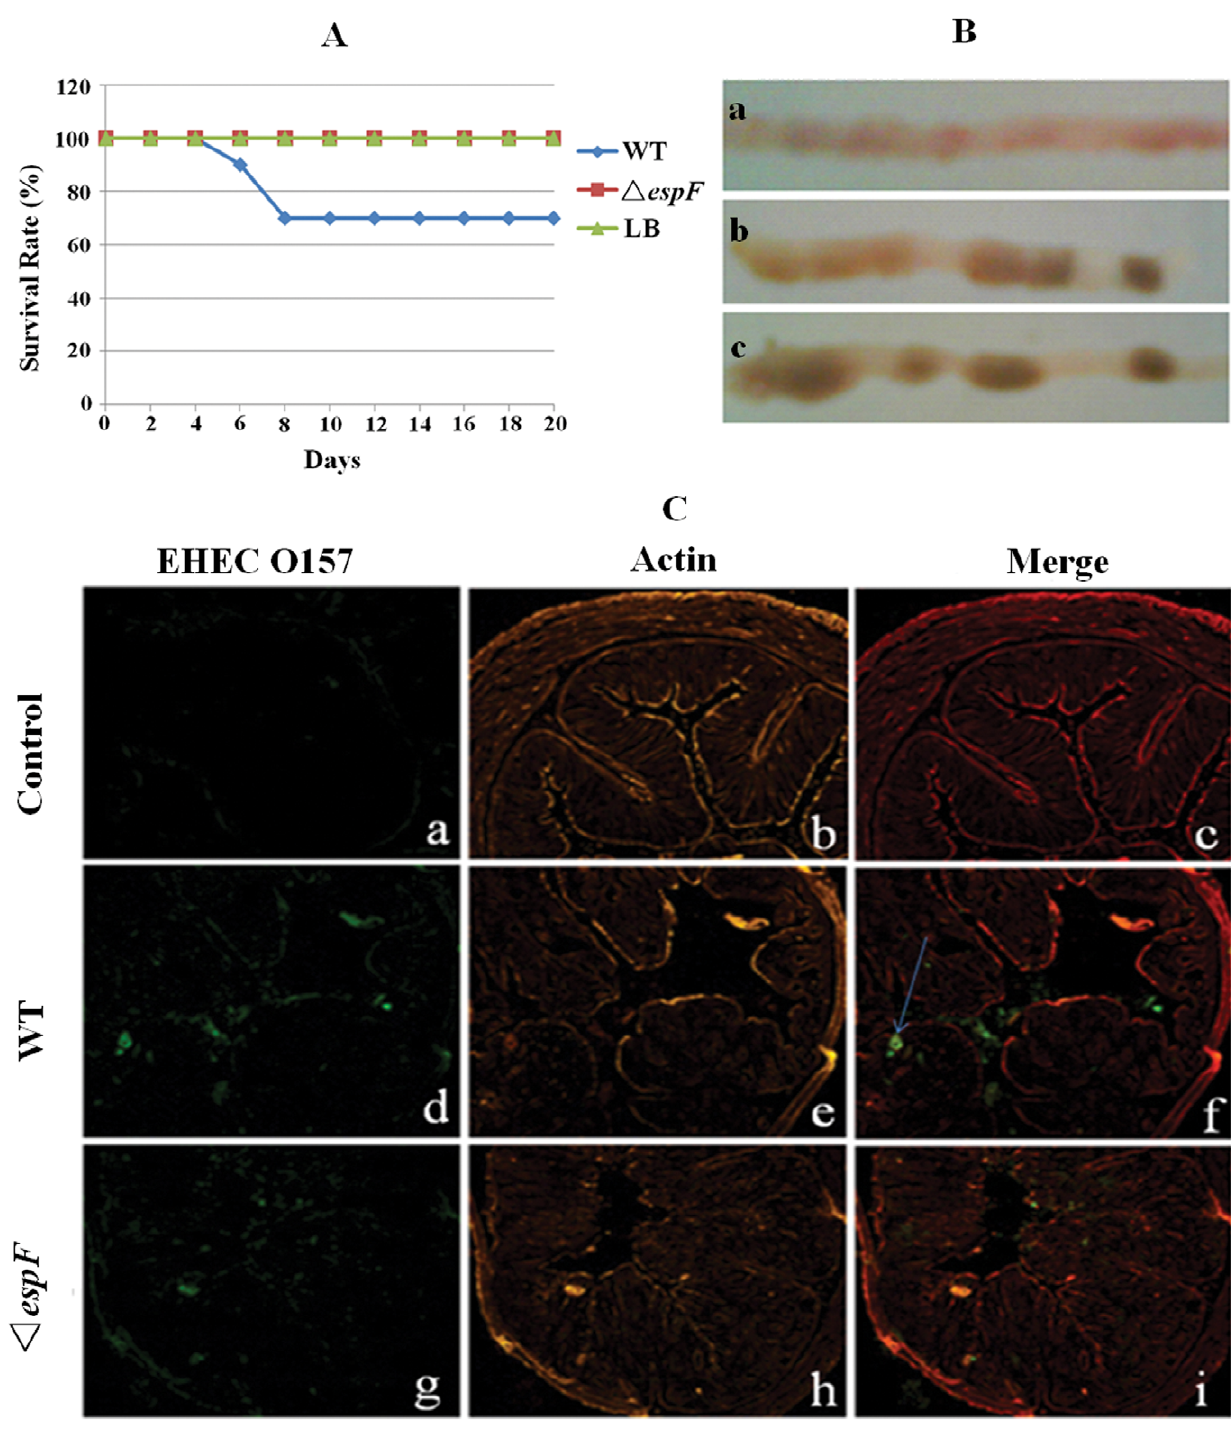
Figure 5. The D espF mutant strain reduces the pathological injury of mouse. (A) Survival curves of BALB/c mice infected with EHEC strains. (B) Typical features of colons after infection. (a) : typical intestinal colitis symptoms in the WT group. (b): healthy colons with slightly swollen areas in the D espF group. (c): healthy colons with solidified feces in control group (mice were fed by LB). (C) Immunofluorescent images of mouse colons infected with wild type group, D espF group and control group. (a, d, g): green fluorescence from immunostainning with anti-EHEC O157 antibody. (b, e, h): orange fluorescence from the actin counterstainning with Rhodamine-phalloidin. (c, f, i): merged images of immunostainning with anti-EHEC O157 antibody and Rhodamine-phalloidin stained colons. doi:10.1371/journal.pone.0055164.g005 D espF strain. The non-infected control group did not display any green and the mtHsp70 red fluorescent signals of each group and green fluorescence signal. We scanned a straight line of the EspF a consistent fluorescent signal strength curve was detected in the